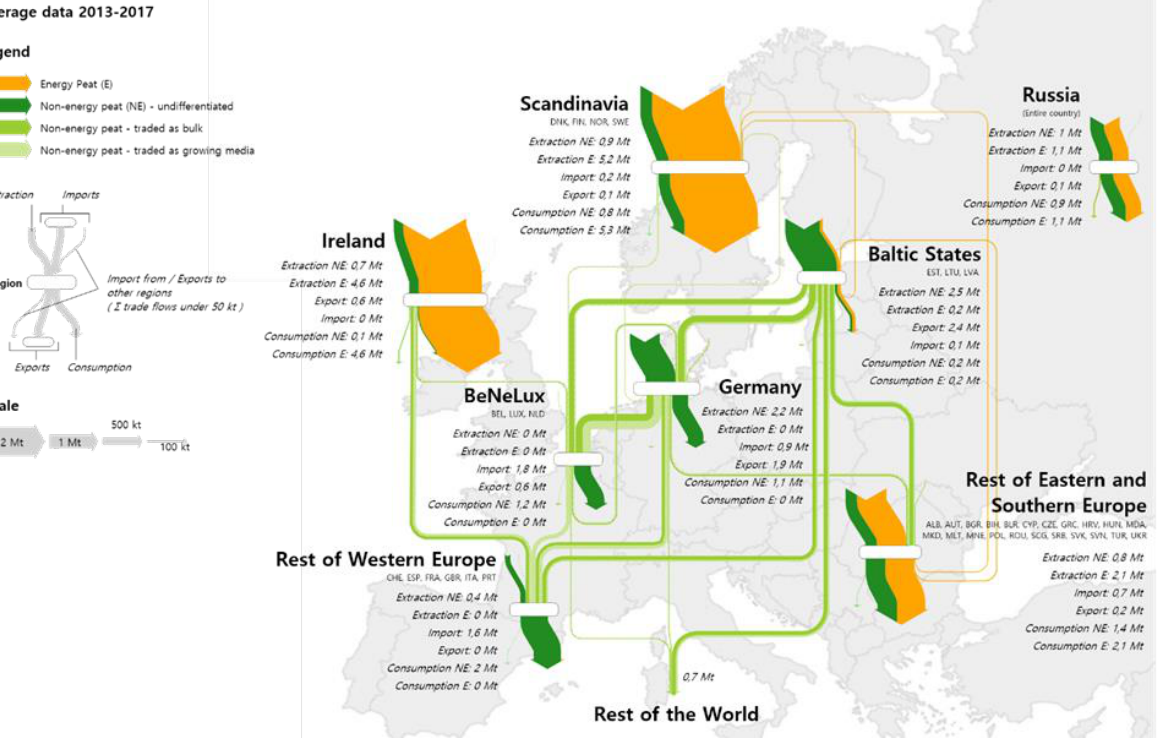
Figure 3. Material flows of energy (E) and non-energy (NE) peat in Europe and Russia. Average data in Mt per year for the period